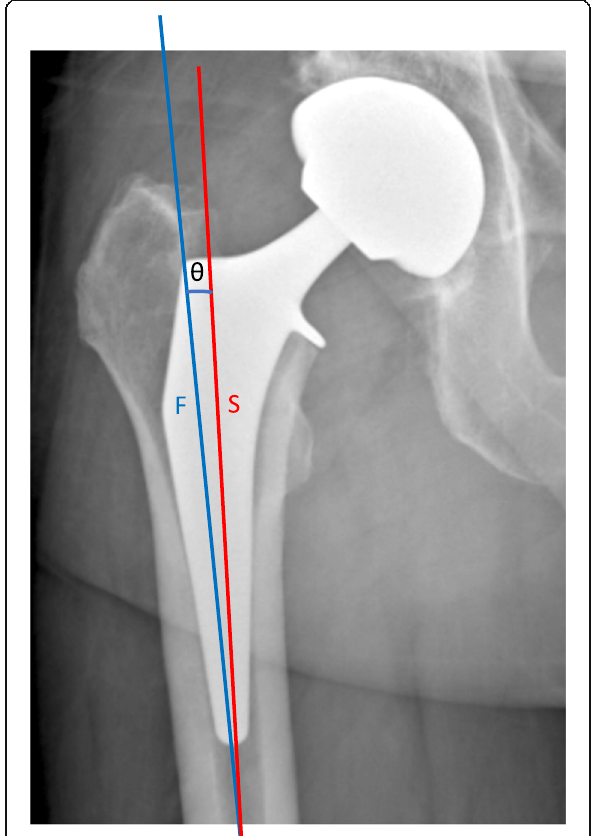
Fig. 3 Postoperative radiograph detailing the measurements of stem axial alignment, that is the angle ( θ ) between the stem axis (S, red; indicated on templates provided by the manufacturer) and the proximal femoral axis (F, blue)